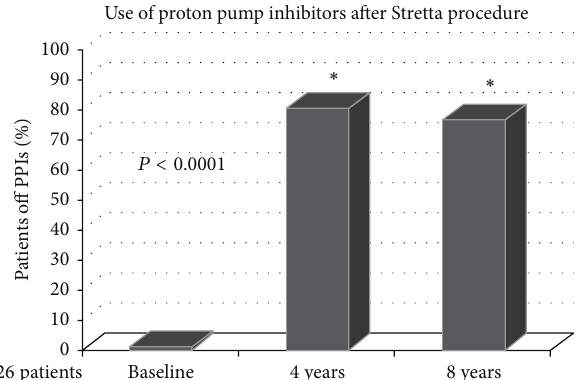
Figure 2: The Stretta procedure significantly reduces the use of antireflux medication. After 4 and 8 years, 21 patients (80.7%, 𝑃 = 0.0001 ) and 20 patients (76.9%, 𝑃 = 0.0001 ) were completely off PPIs (including OTC-PPIs and anti-H2